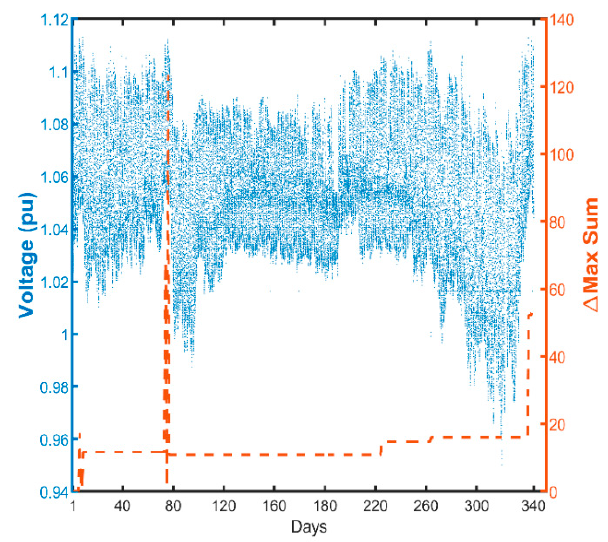
Figure 9. Worst day estimation from a one-year dataset.